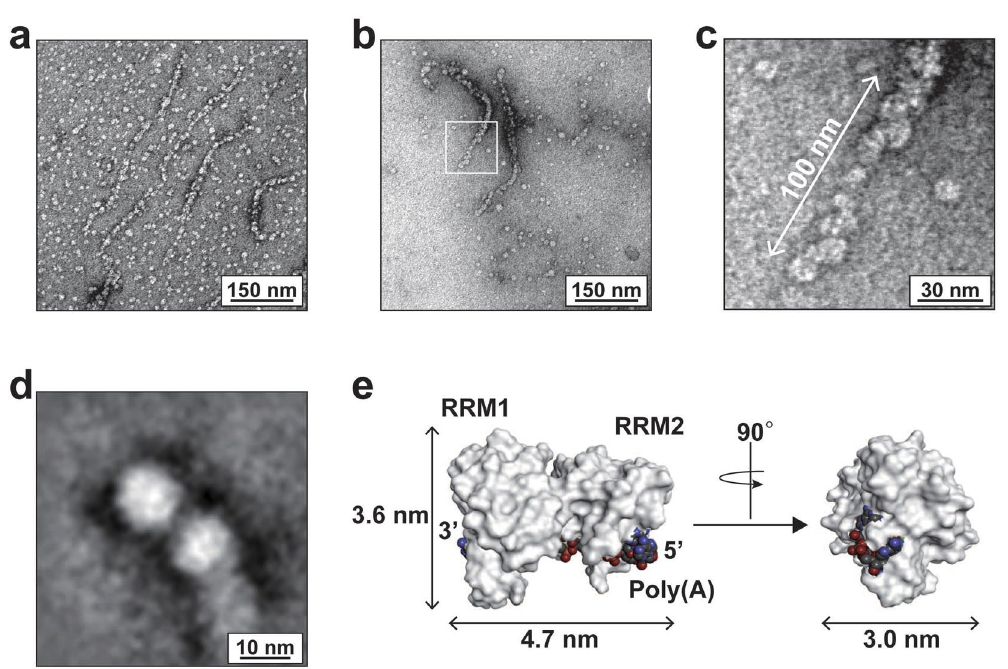
Figure 2. TEM images of poly(A)-bound PABPC1. ( a , b ) TEM images of the negatively stained samples. ( c ) Enlarged TEM image of the white box region in ( b ). ( d ) The averaged TEM image. ( e ) Size of the A 9 -bound RRM1/2. A 9 and RRM1/2 (PDB 1CVJ 37 ) are drawn as CPK and surface representations,